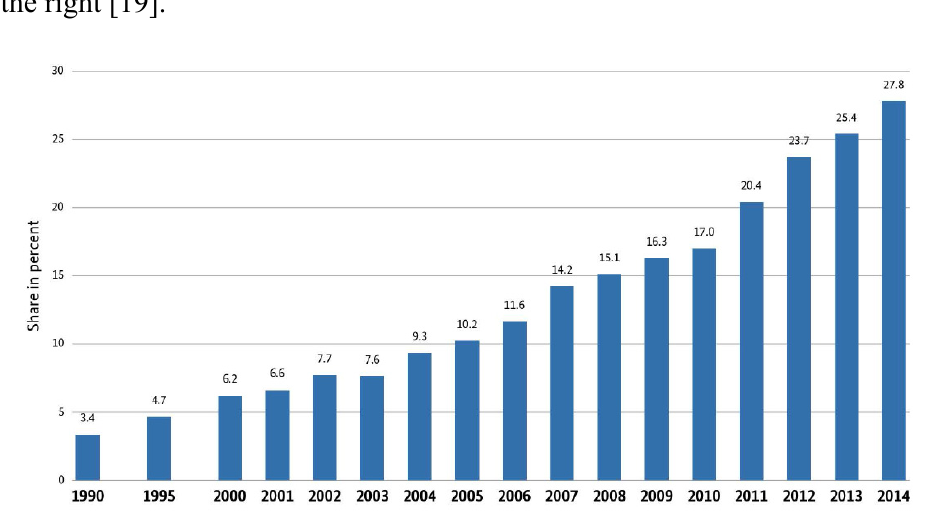
Figure 1. Development of renewable energy share of gross electricity consumption in Germany